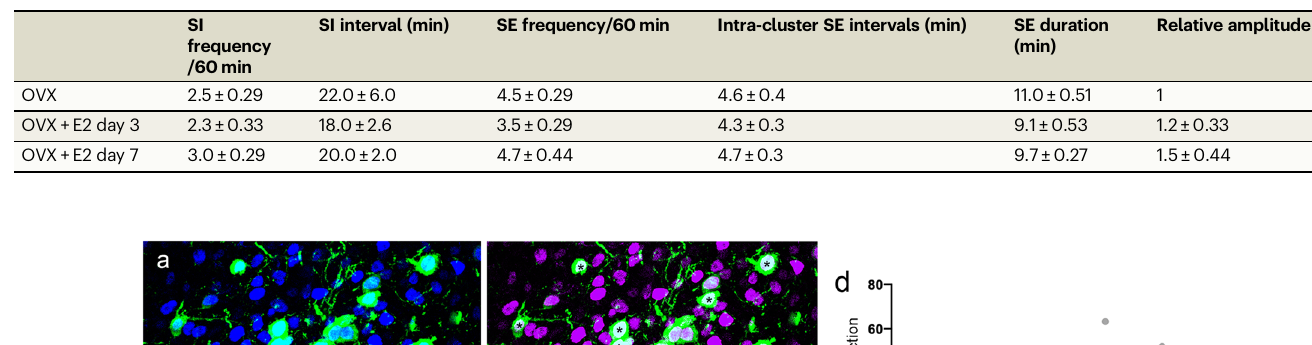
Table 1 | ARN KISS neuron synchronization event (SE) dynamics in OVX KERKO mice with and without E2